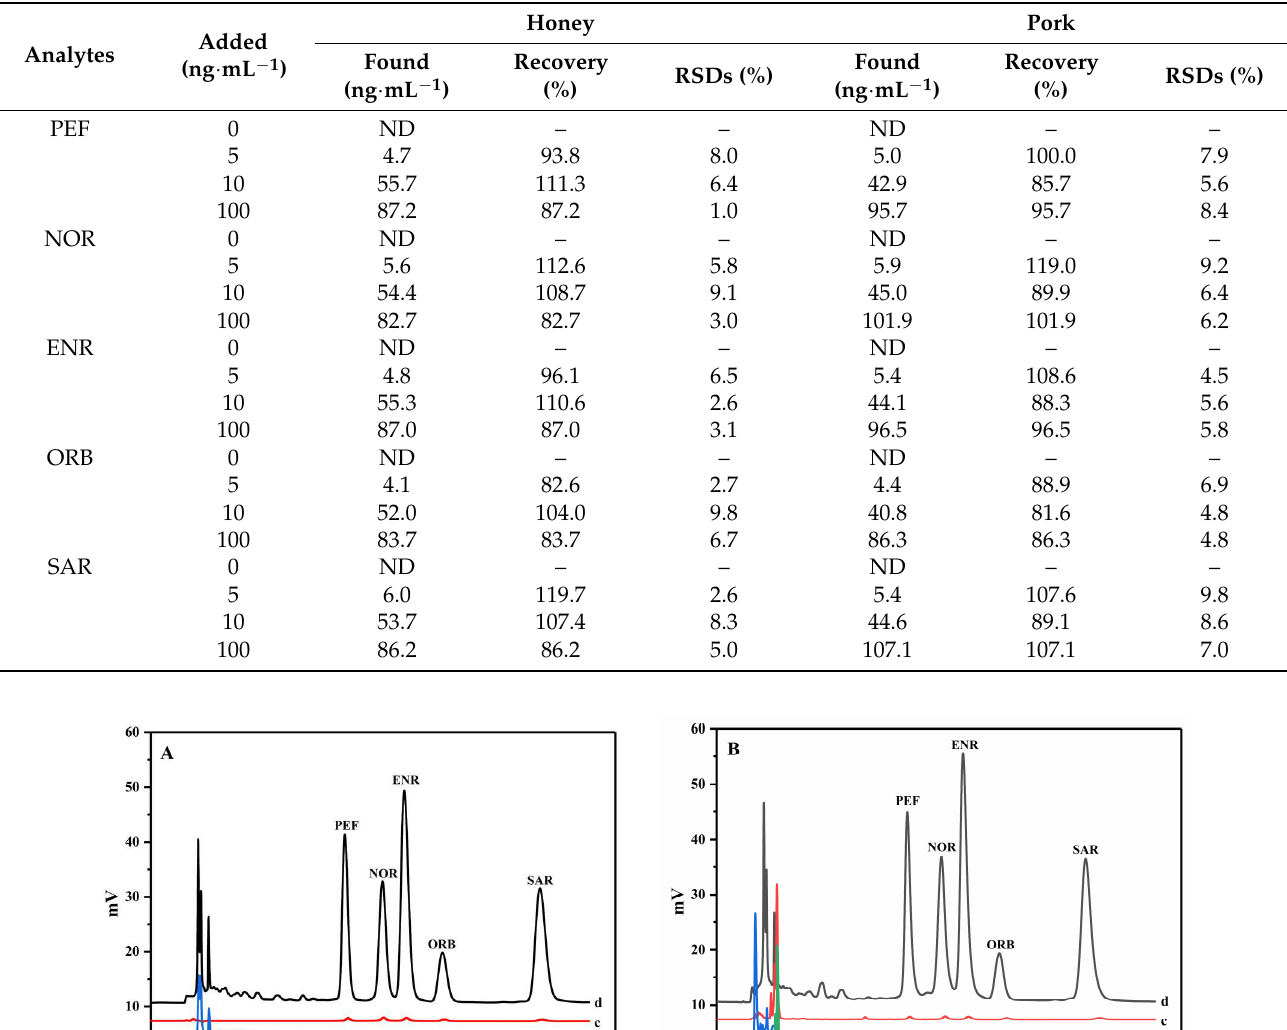
Table 2. The determination of five QAs in honey and pork samples ( n = 3).